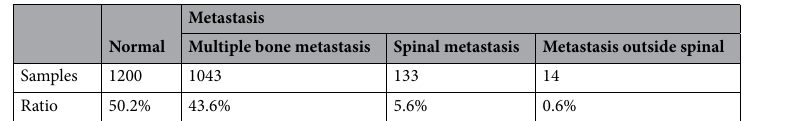
Table 2. Overview of the augmented data of thoracic images. (n = 2390).